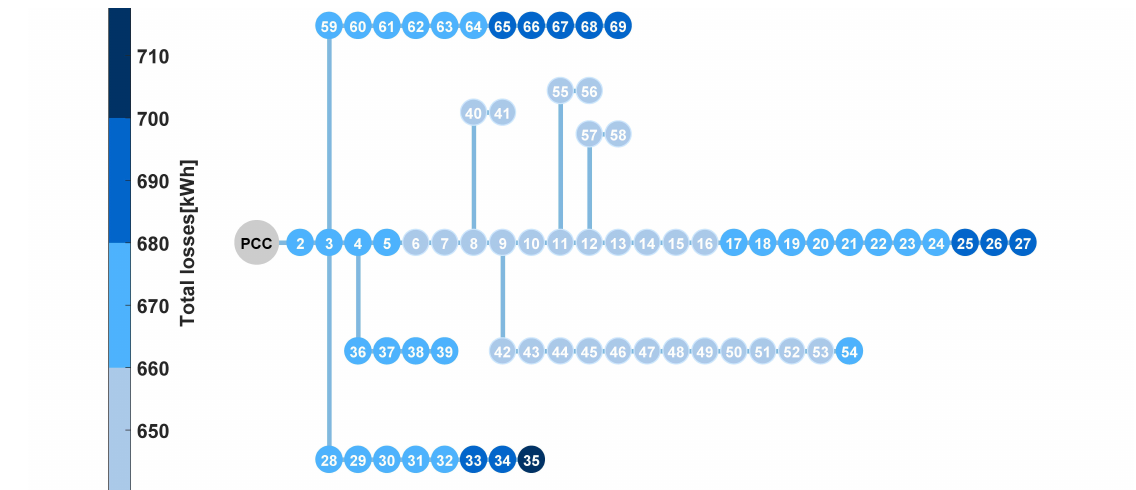
Figure 5. Monthly energy losses associated to each different location of the BESS. The losses are given by means of a color code, described in the legend. Table 1. Comparison of monthly costs with and without a BESS.